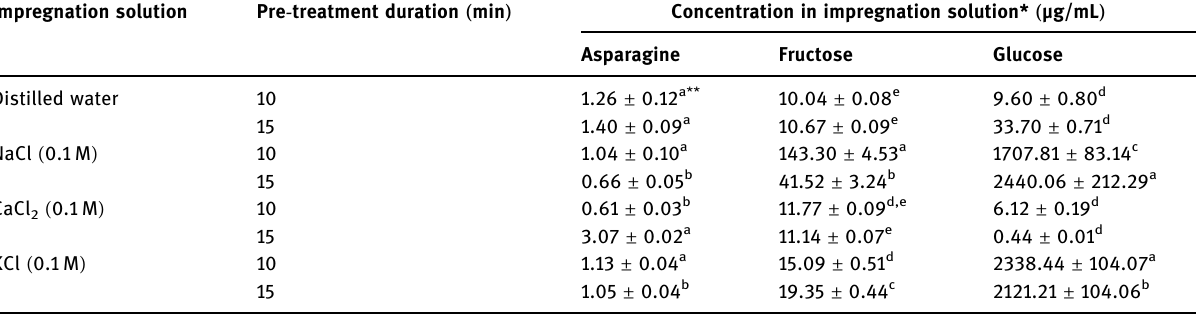
Table 1: Changes in asparagine, fructose, and glucose contents of four di ff erent impregnation solutions after the VI pre - treatment of potato strips for two di ff erent